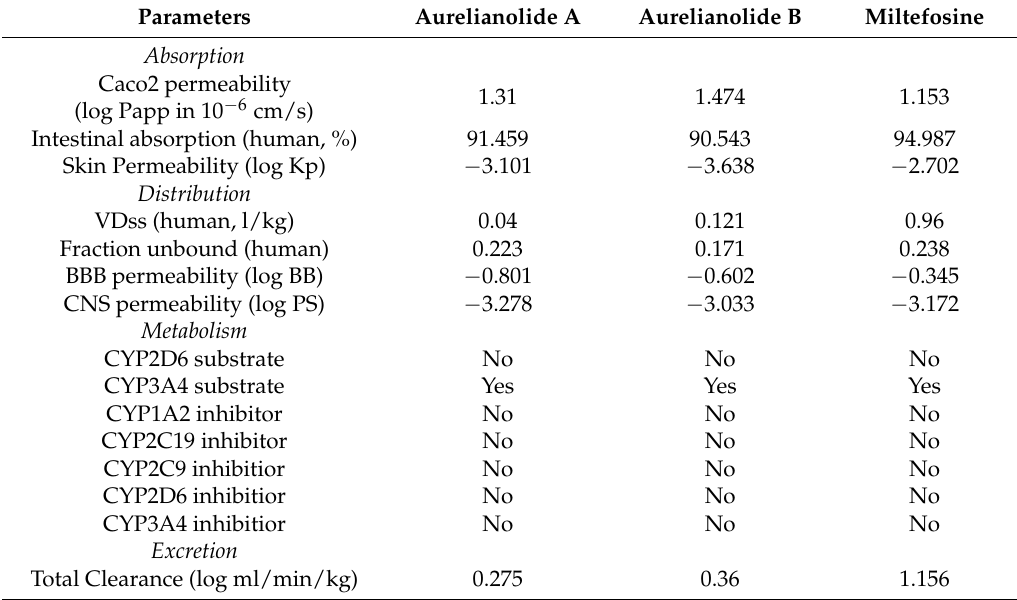
Table 3. In silico ADME (absorption, distribution, metabolism, excretion) properties of Aurelianolides and miltefosine using pkCMS tool *.